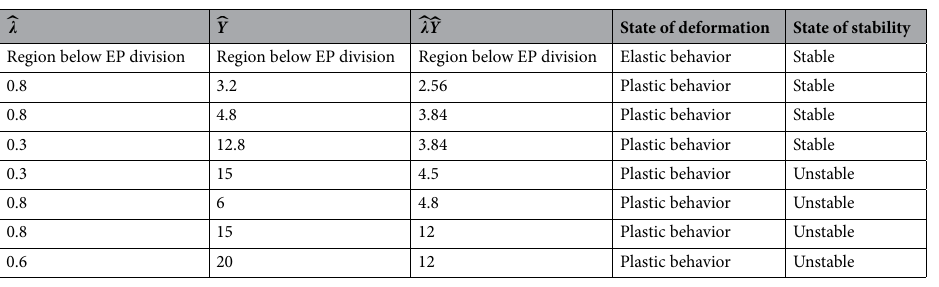
Table 1. Details for results in Fig.